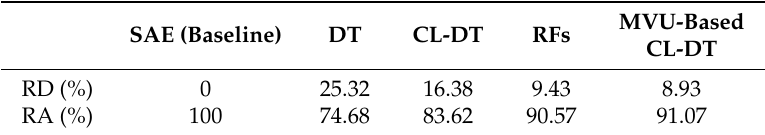
Table 4. The relative difference (RD) of classification results and relative accuracy (RA) in the 1st test area.